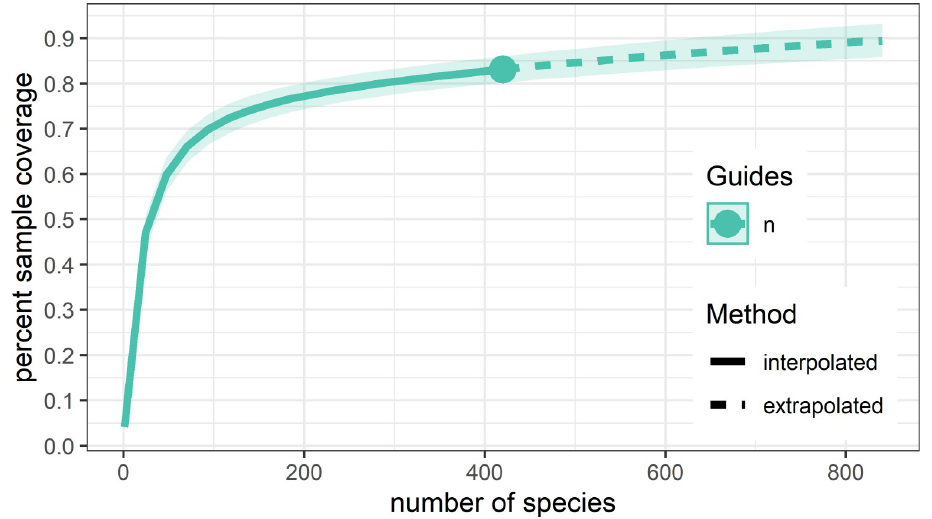
Fig 3. Rarefaction sample coverage curve. Observed sample coverage reaches 83% for the 420 sample representative taxa. Extrapolated sample coverage reaches 90% by doubling the number of sample representative taxa.